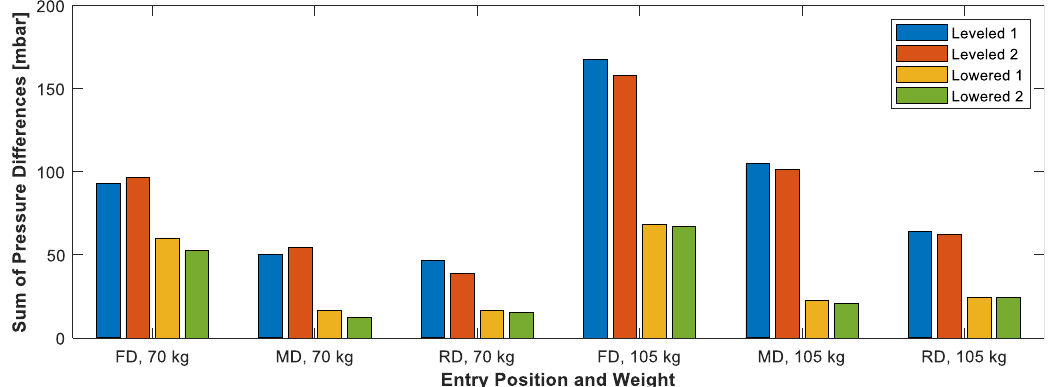
Figure 13. Overview of all accumulated pressure changes from all six air suspensions for two test persons and all three doors.